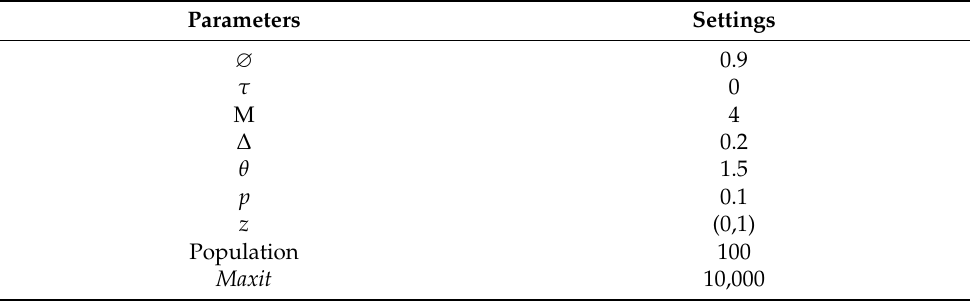
Table 3. Parametric settings for the proposed algorithm provided by